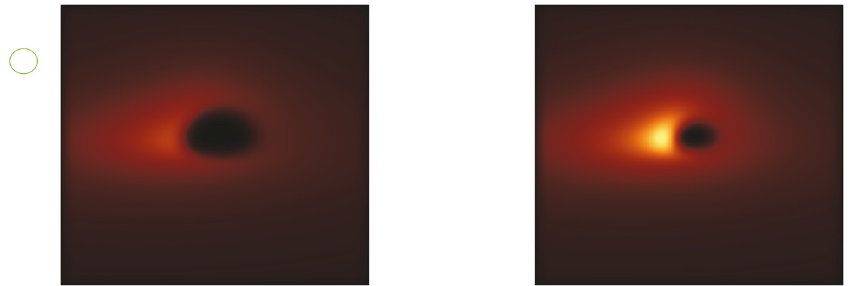
Figure 4: Infinite, counterclockwise rotating geometrically thin accretion disc around static and rotating compact objects viewed from an inclination of 60 ∘ and 𝑎 = 0.6 . The left panel is GR and the right one is pc-GR. A resolution of 20𝜇𝑎𝑠 was assumed. A resolution of 20𝜇𝑎𝑠 is assumed.